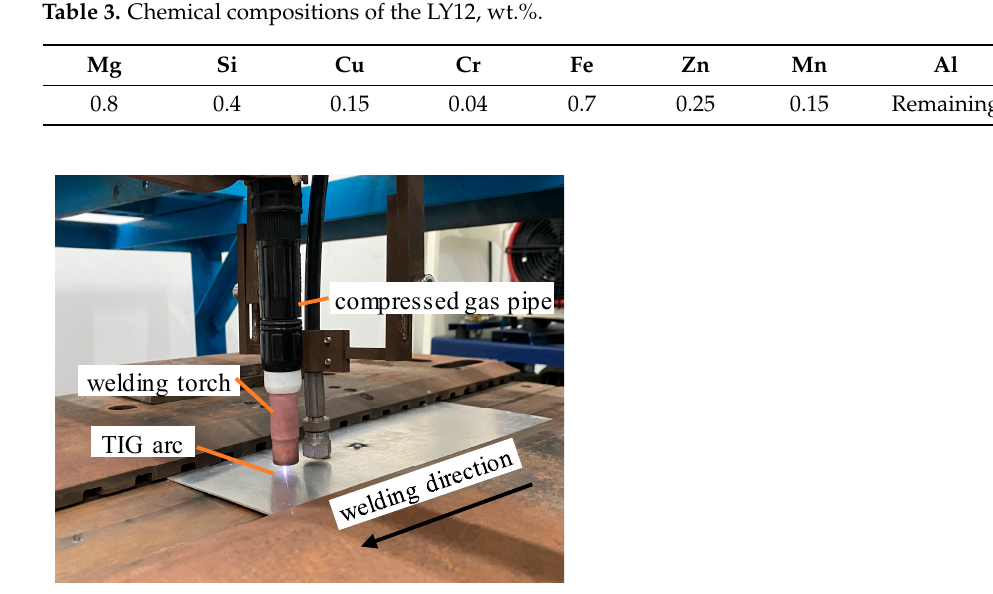
Figure 10. Image of the high-speed gas fluid field device used during the welding process. Table 4. Welding process parameters of automatic TIG welding.